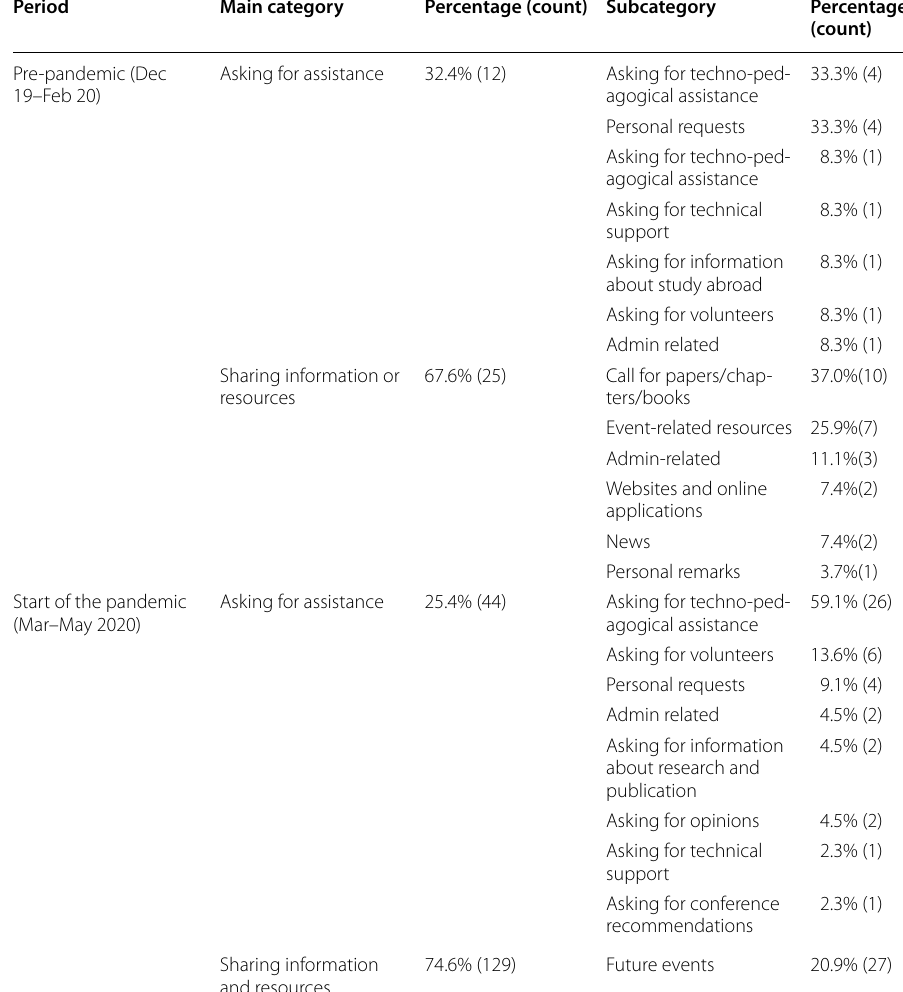
Table 5 Types of posts before and during the pandemic